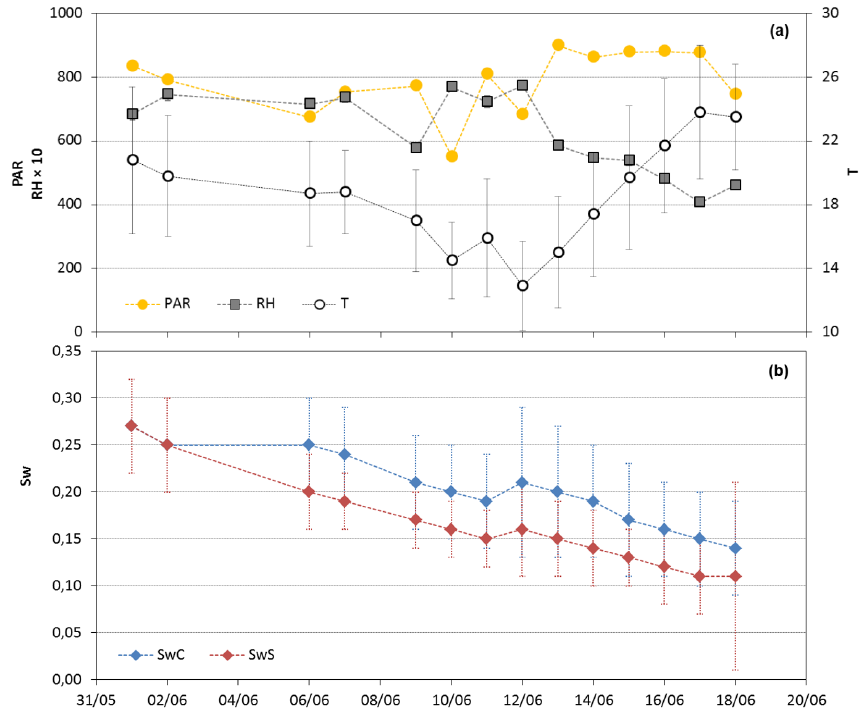
Figure 2. Environmental conditions prevailing at the O 3 HP site. (a) Daily mean photosynthetically active radiation PAR (µmolm − 2 s − 1 ) , temperature T ( ◦ C) and ambient relative humidity RH (%) measured above canopy (6.5mabove ground) and (b) soil water content Sw ) recorded in the control (C, six different probes) and rain exclusion plots (S, five different probes) at − (L H L − 1 soil 2 O